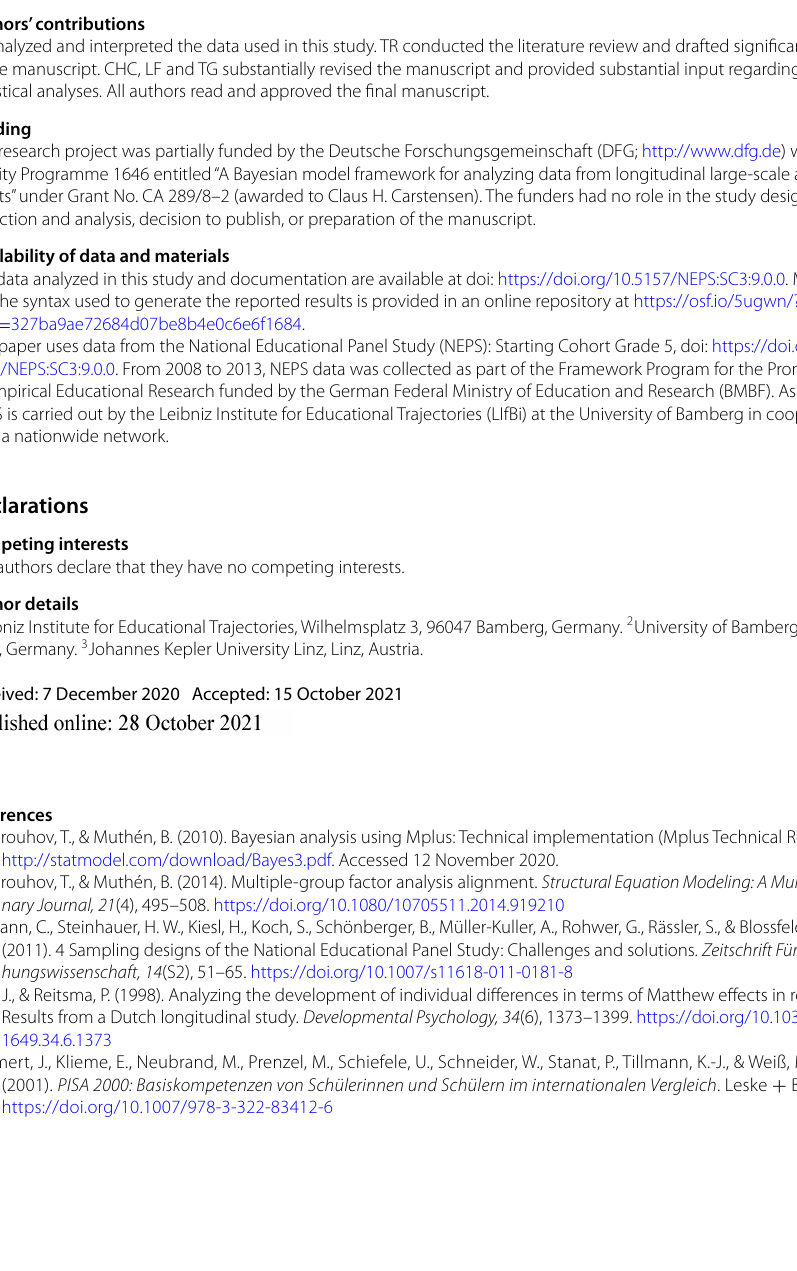
7276) with cluster robust =